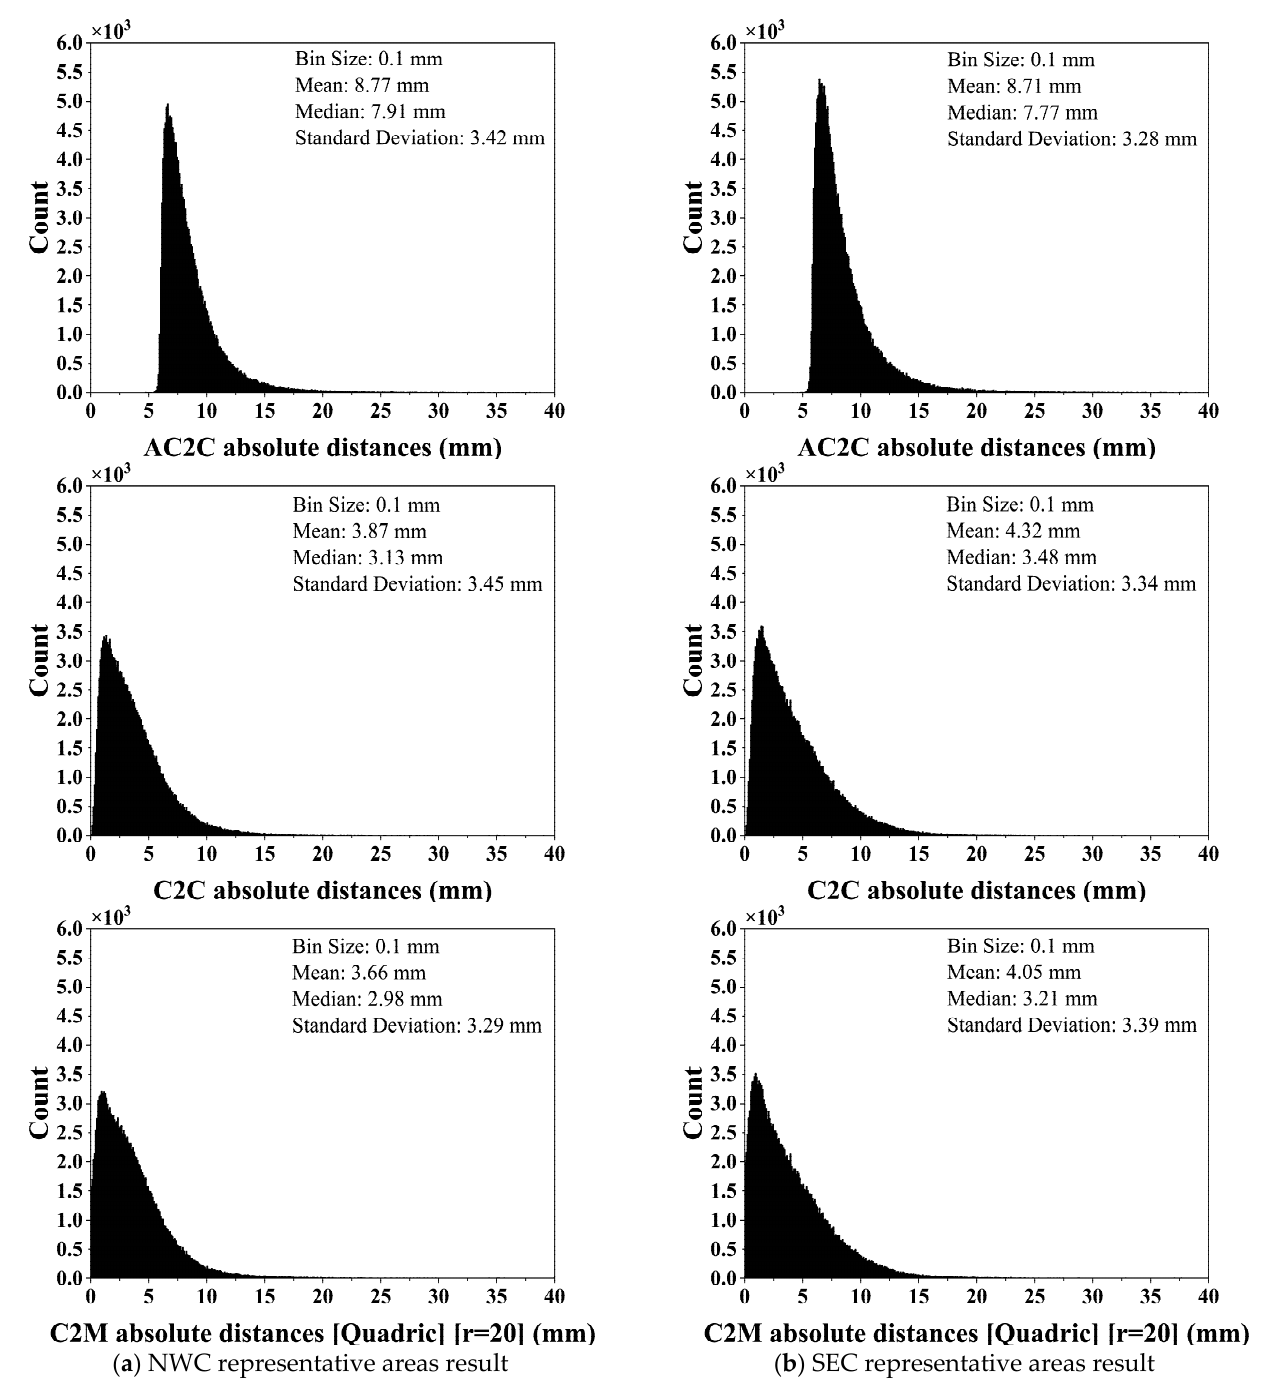
Figure 13. Absolute distances calculation result for ( a ) NWC and ( b ) SEC.